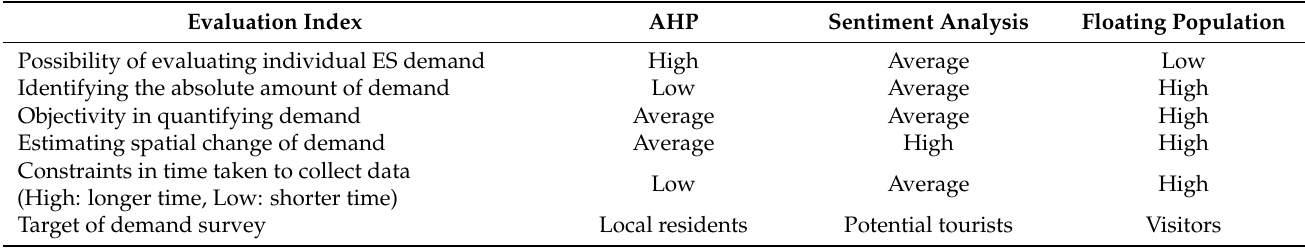
Table 8. Comparisons and characteristics of the three methods measuring the forest ecosystem services demands. Evaluation